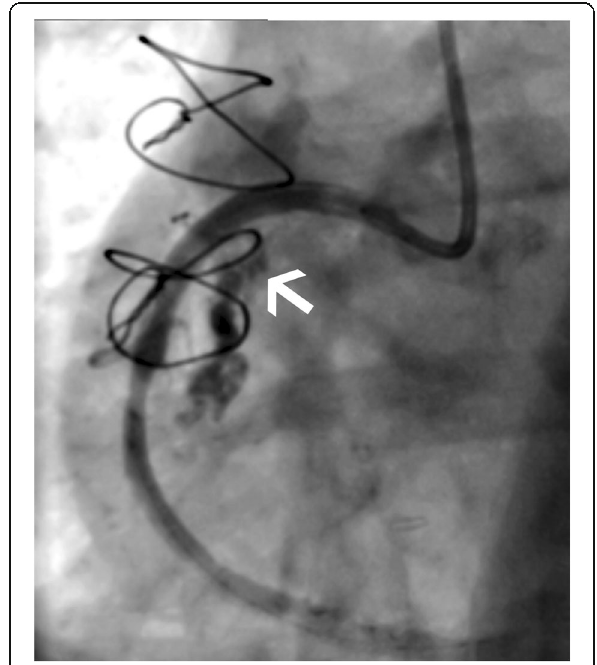
Fig. 2 AP projection showing large extravasation of contrast (white